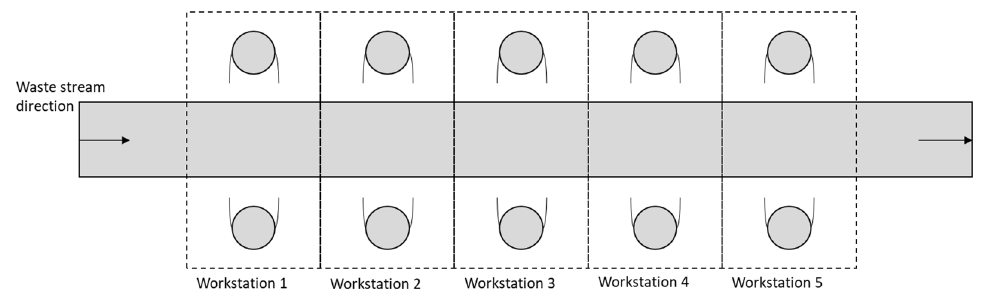
Figure 9. Scheme of the sorting line.